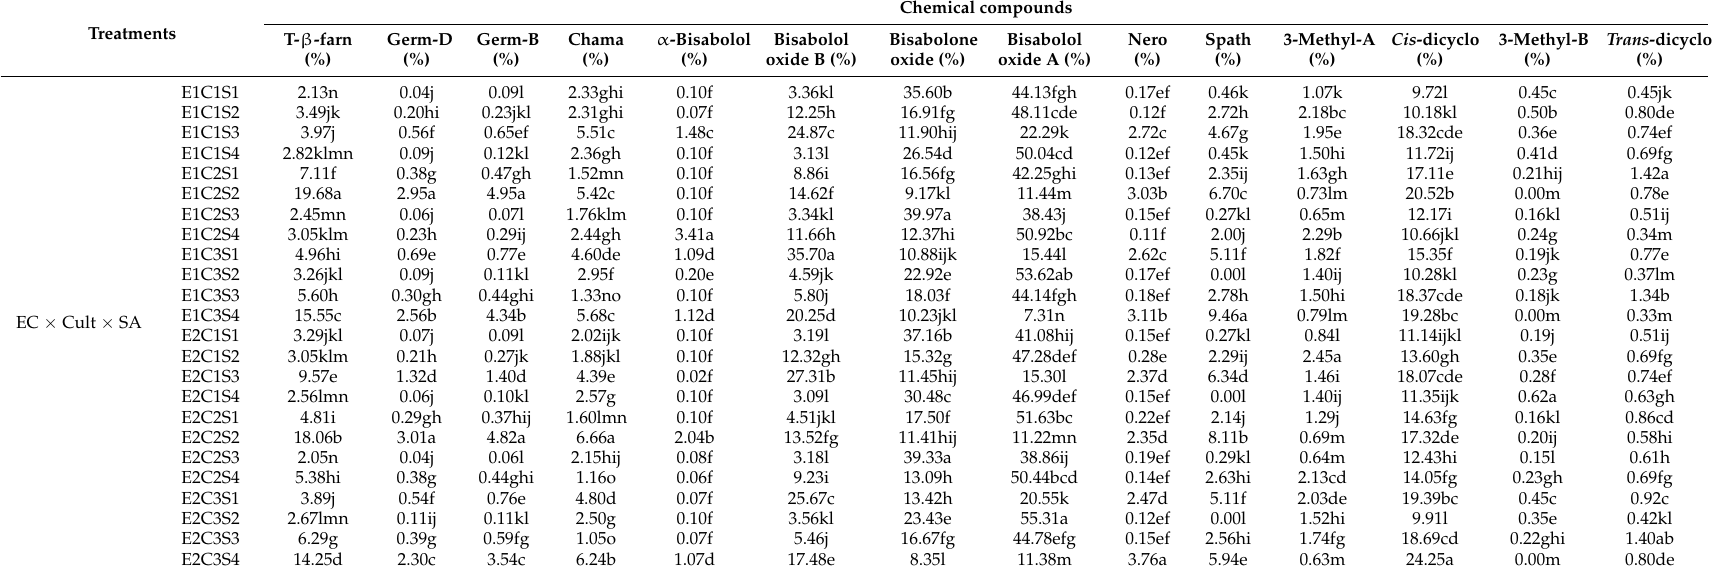
Table 3. Mean comparison of the triple interaction of environmental conditions × cultivar × salicylic acid on chemical compounds of German chamomile.